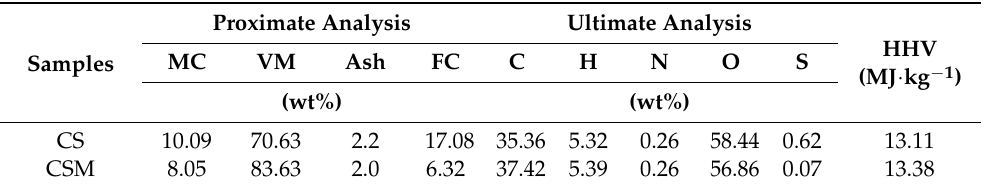
Table 2. The proximate and ultimate composition of CS and